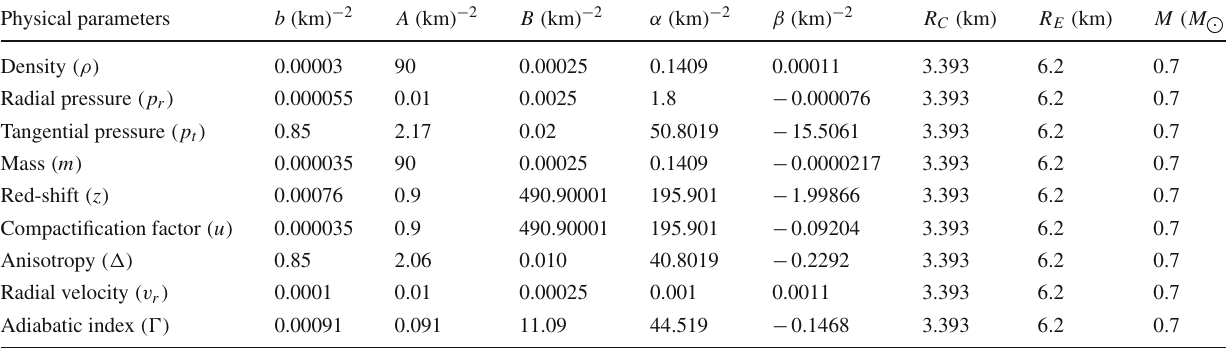
Table 1 Calculated values of parameters that give core radii ( R C , mass and envelope radii R E ) for SAX J 1808 . 4-3658